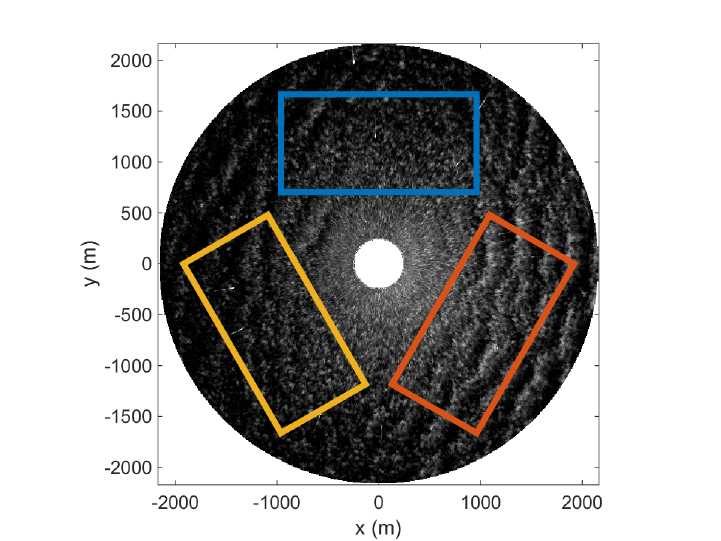
Figure 1. Single scan converted radar image with 3 uniformly distributed analysis